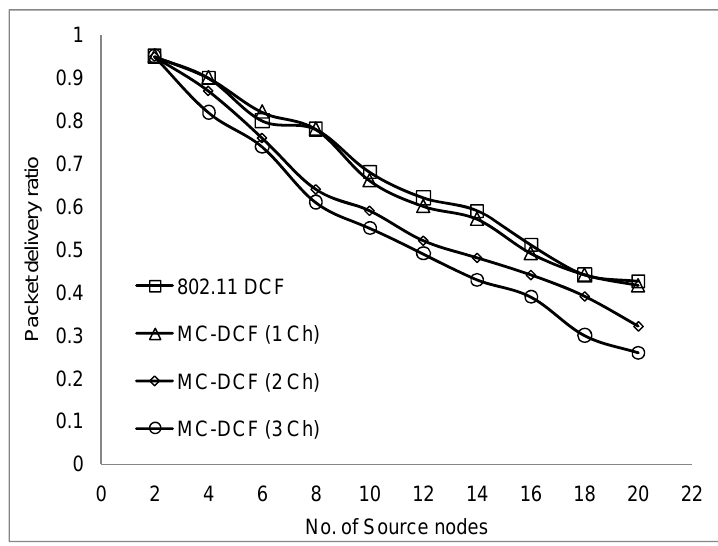
Figure 17. Delivery ratio at sink receiving packets from source